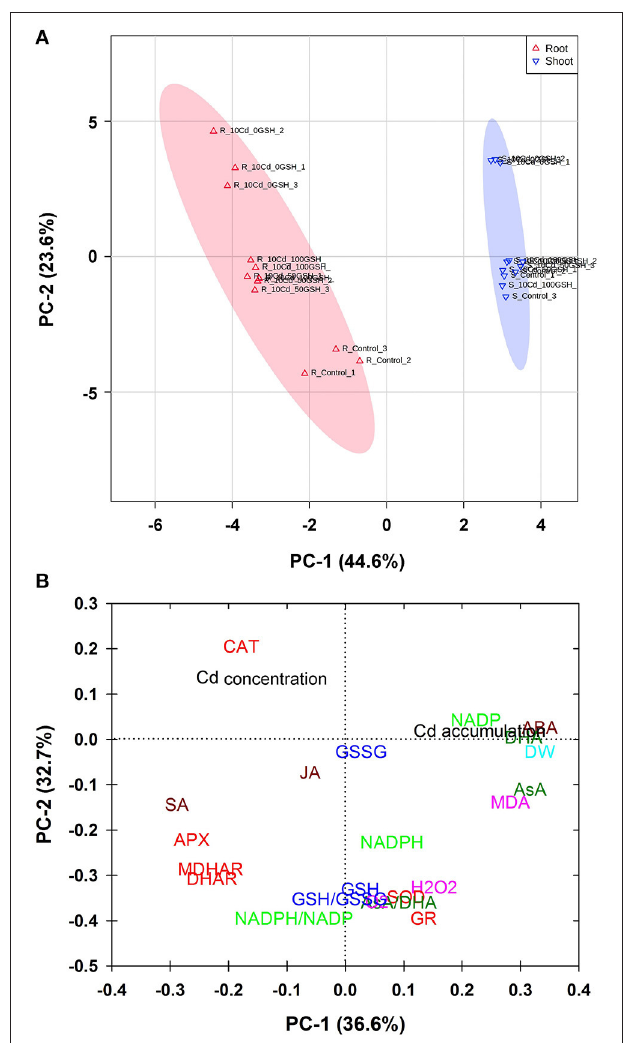
FIGURE 8 | (A) Plot of principal component analysis (PCA) scores of untreated controls (no Cd or GSH) or Cd-stressed plants receiving 0, 50, or 100mg kg − 1 GSH and (B) loading plot of ROS, AsA/GSH/NADPH redox status, and stress-associated hormone status in the roots and shoots of Cd-stressed plants treated with different GSH concentrations. R, root; S,